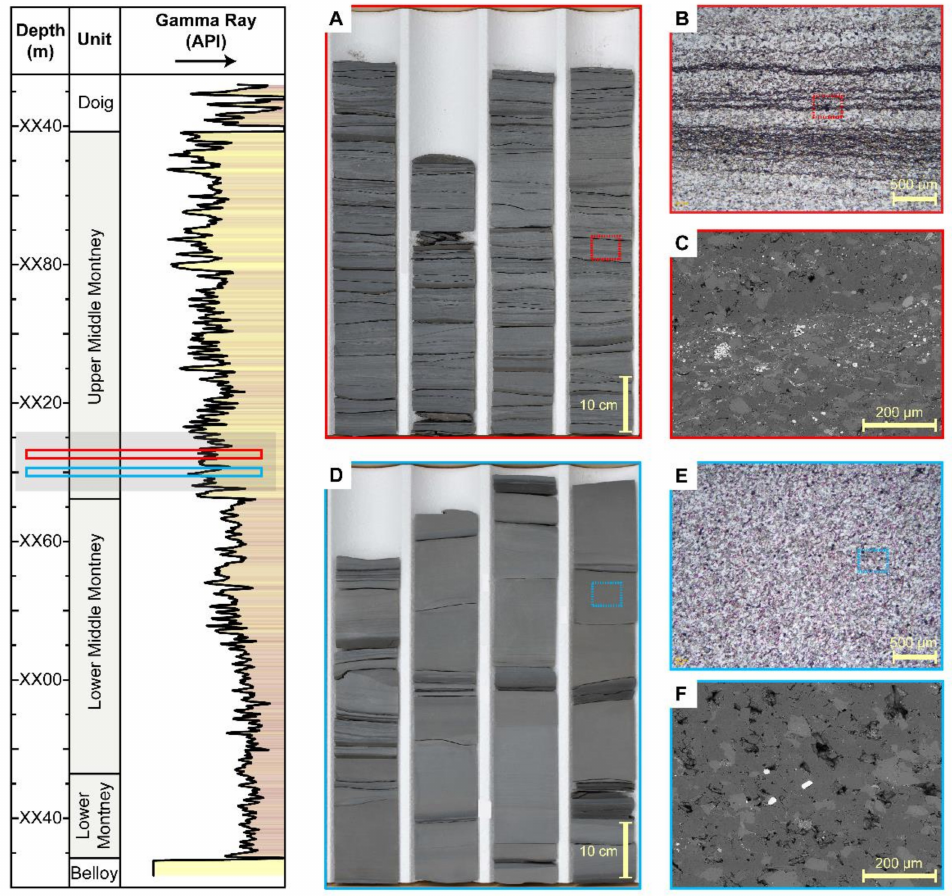
Figure 2. Gamma ray log from the Montney vertical reference well used in this study to constrain the log-based calculations and laboratory results from the horizontal subject well. The shaded rectangle in the panel on the left represents the estimated interval crossed by the horizontal well. The core pictures ( A , D ), thin section images ( B , E ), and SEM images ( C , F ) represent examples of the rocks encountered by the horizontal well. Lithostratigraphic framework from Davies et al.